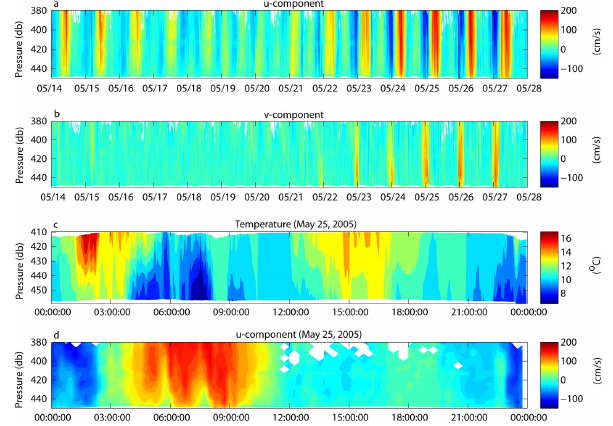
Fig. 11. The east-west (a) and north-south (b) current components for one fortnightly cycle of currents at mooring L1 in the Luzon Strait. The temperature (c) and east-west component (d) for 25 May 2005 are expanded in the two panels below. White spaces indicate missing or bad data.